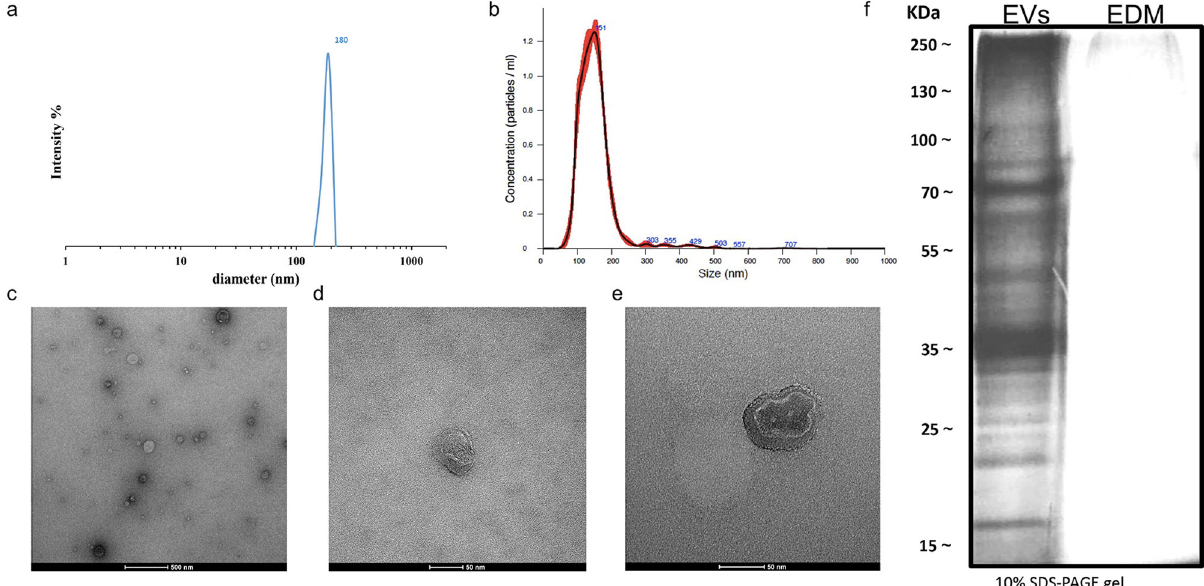
Fig. 2 Biophysical characterization of HR-derived EVs. a EVs size distribution curve obtained by dynamic light scattering (DLS). b Nanoparticle Tracking Analysis (NTA) measurements show the distribution of the EV size with the major peak at 151 nm. c TEM image of isolated vesicles exhibiting round- shaped morphology. d , e Close-up view images of individual HR-derived EVs. f Protein pattern of HR-derived EVs and EV depleted-medium (EDM) visualized by SDS-PAGE and silver staining. Silver staining of EDM did not show detectable proteins. Scale bars: 500 nm in c , 50 nm in d, 50 nm in e